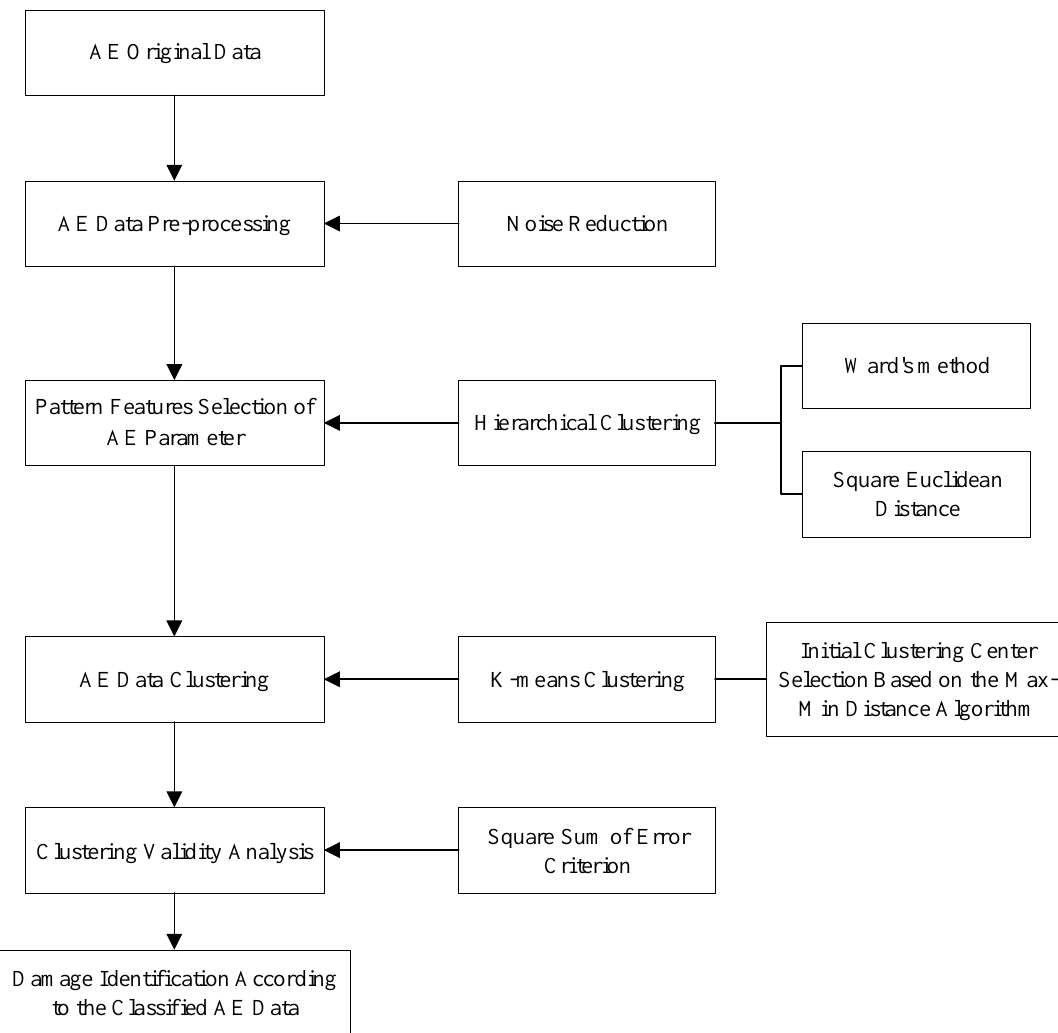
Figure 4: Flow chart of unsupervised pattern recognition technique